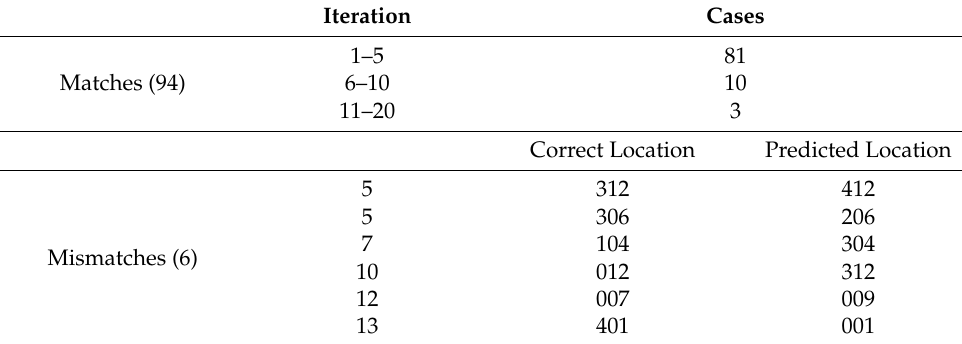
Table 6. Test results using only roll and pitch motions as